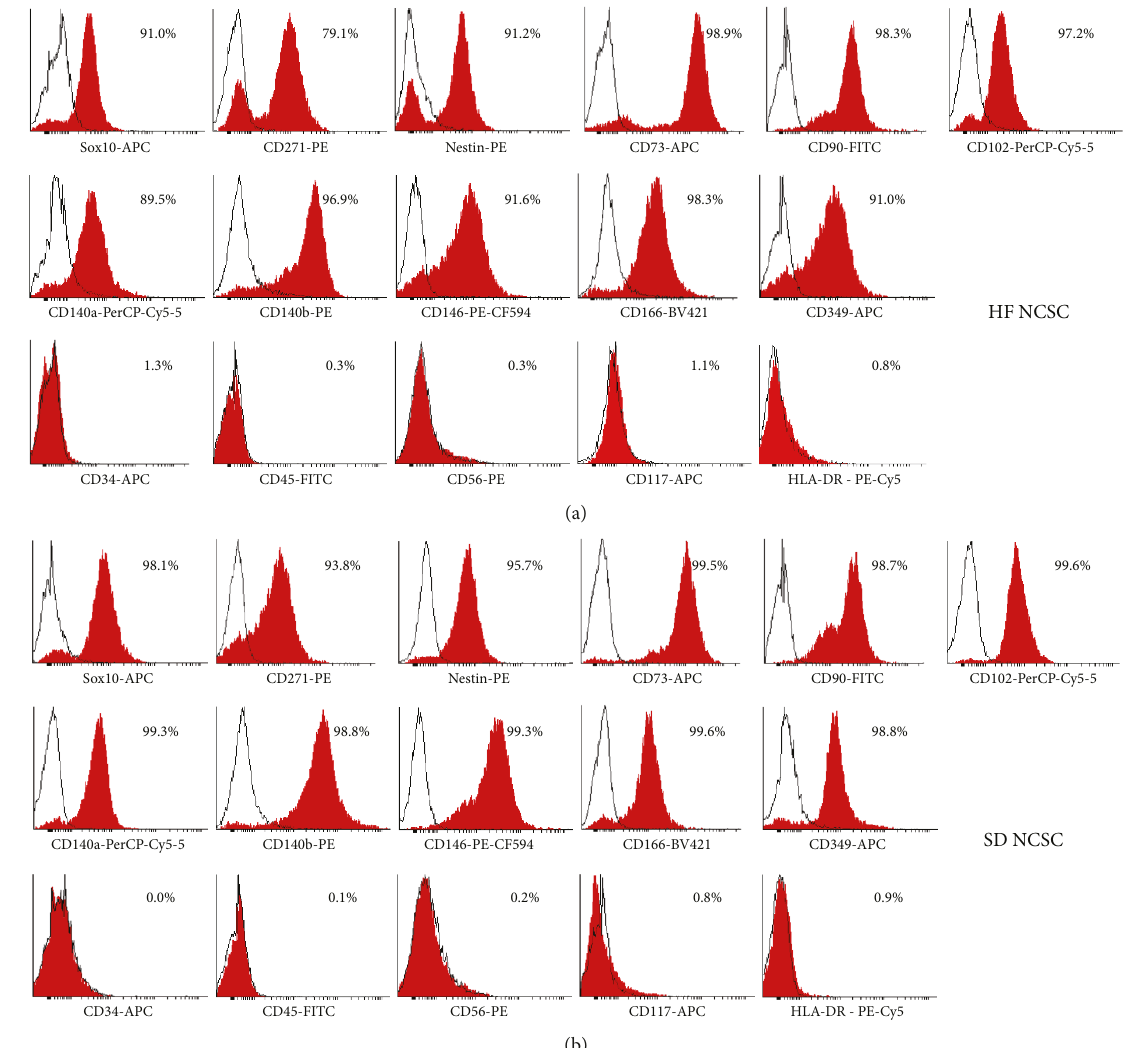
Figure 5: Representative FACS histograms from donor 1. (a) HF NCSCs. (b) SD